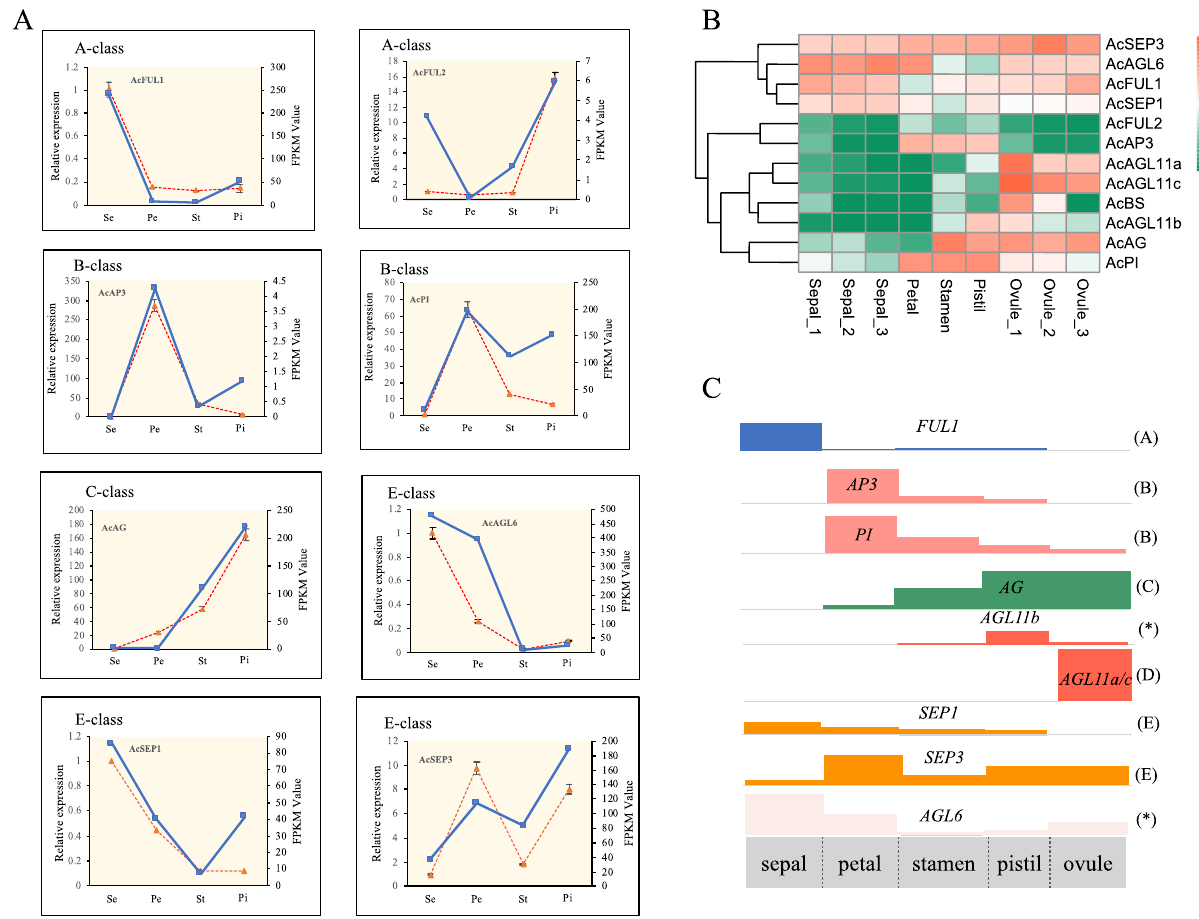
Figure 8. Floral organ-specific expression patterns of AcMADS genes and a deduced pineapple ABCDE model. ( A )The left y-axis scales the relative expression of RT-qPCR result and Blue solid line indicated values of RT-qPCR.The right y-axis scales the FPKM value from RNA-seq result(stage1 sepal, petal, stamen, pistil) and orange dashed line indicated values of RT-qPCR. ( B ) Heatmap plot of expression patterns of pineapple A-, B-, C-, D-, E-class genes from another pineapple tissue-specific transcriptome. ( C ) A proposed pineapple flower model based on the expression patterns and referring to the ancestral functions of homeotic MADS-box genes. Blocks in different colors with distinct heights represent different expression levels. Gene functions for specific members are in brackets. *The gene function is difficult to predict because an expression split has occurred. The gaps are linked with grey